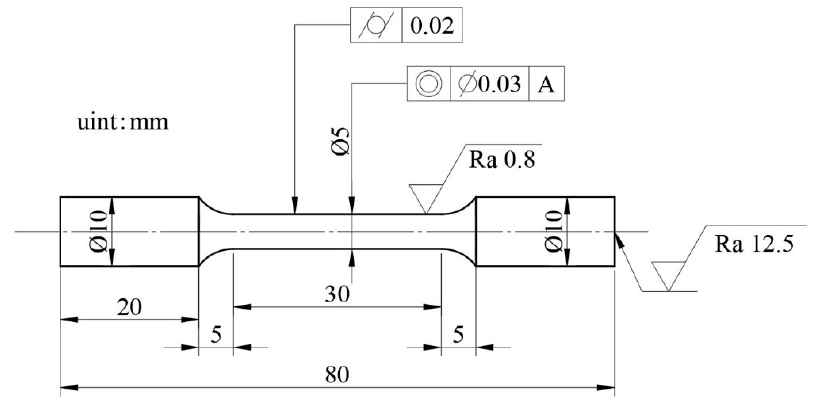
Figure 2. Geometry and size of specimens used for room-temperature tensile tests.